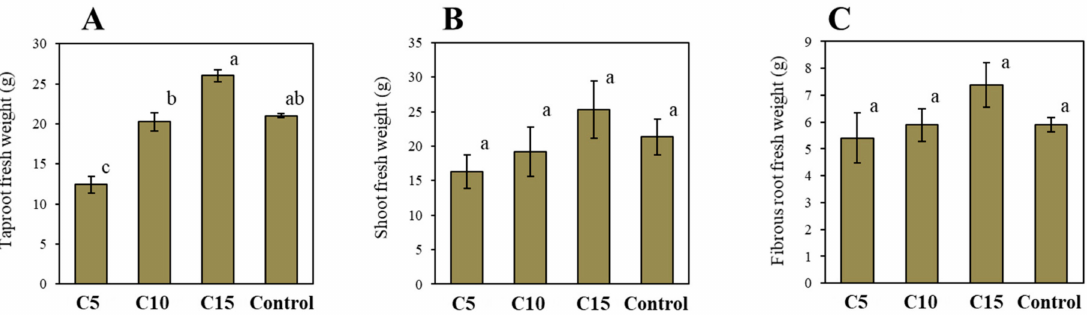
Figure 5. E ff ect of partial taproot excision on fresh weights of taproot ( A ), shoot ( B ), and fibrous root ( C ) of carrots 28 days after partial taproot excision. Vertical bars represent the means ± SE ( n = 4). Di ff erent letters indicate significant di ff erences as determined by Tukey’s multiple comparison test ( p < 0.05).